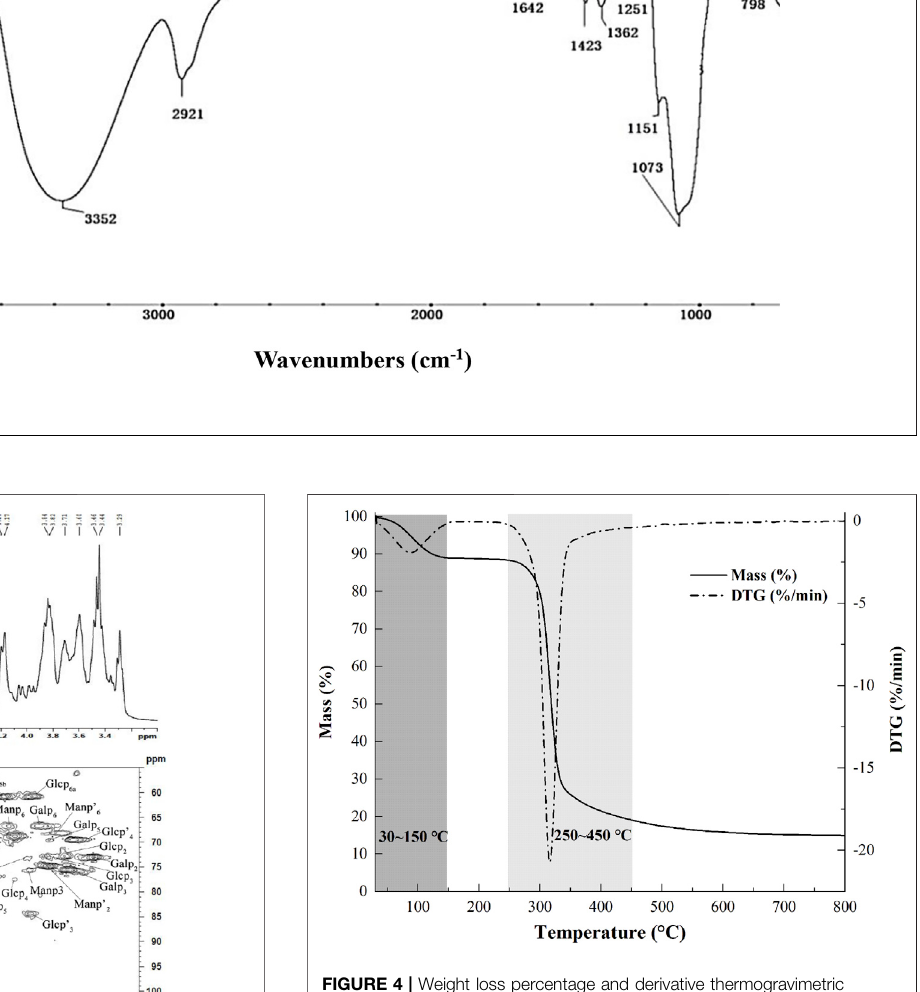
FIGURE 4 | Weight loss percentage and derivative thermogravimetric curves of